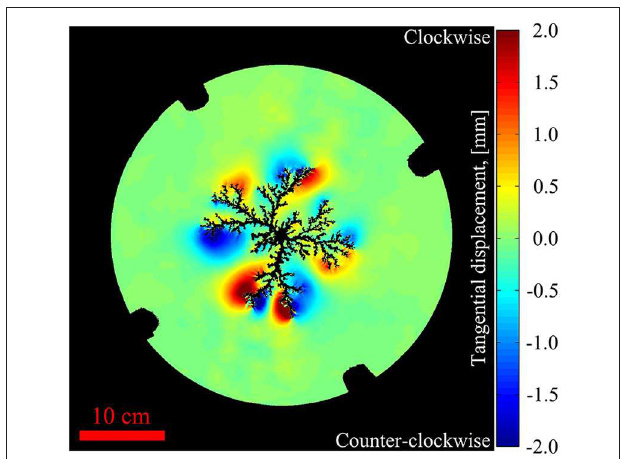
FIGURE 10 | Example of tangential displacement behavior taken from the interval of 448–488ms (50–54% of breakthrough time) for the confined deformable experiment with 100 hPa injection pressure. Blue color means counter-clockwise displacements and red means clockwise displacements. The air cluster and area outside of the cell are shown in black, and the black bumps at the cell rim are due to the